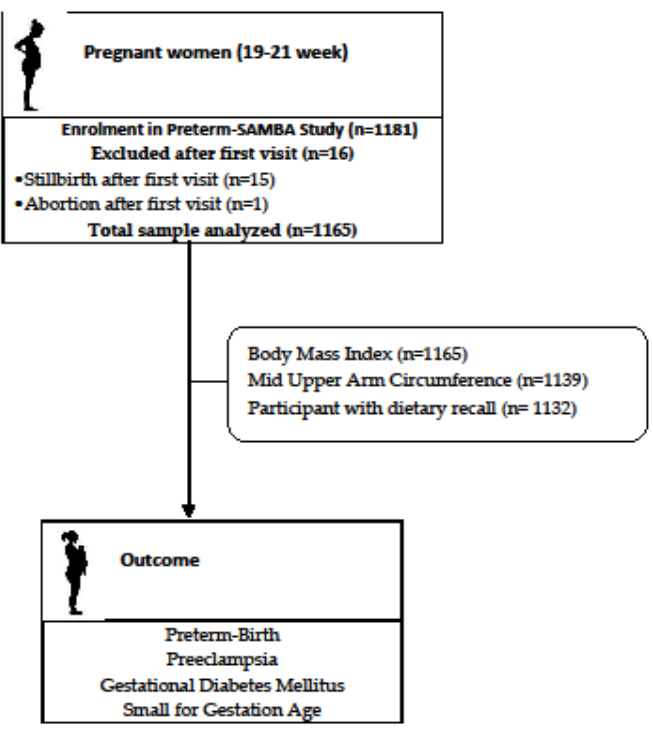
Figure 1. Flow chart of the study sample.